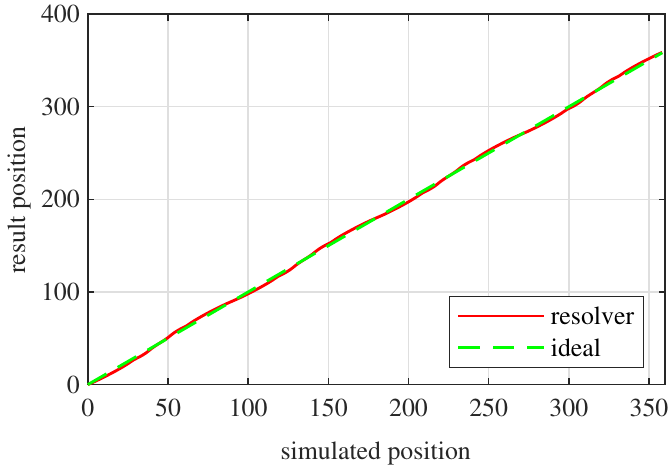
Figure 14. Short pitch four-slot skewed resolver position vs. the ideal position.